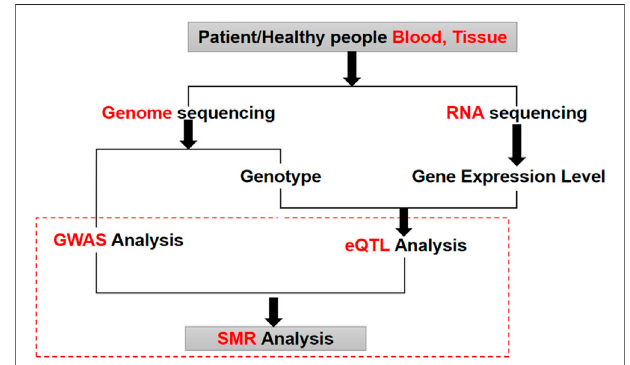
FIGURE 1 | The process of GWAS and eQTL conjoint analysis. GWAS analysis and eQTL analysis are two different types of omics analysis. Using SMR method can discover the biological mechanism behind lung cancer by combining these two different omics data.